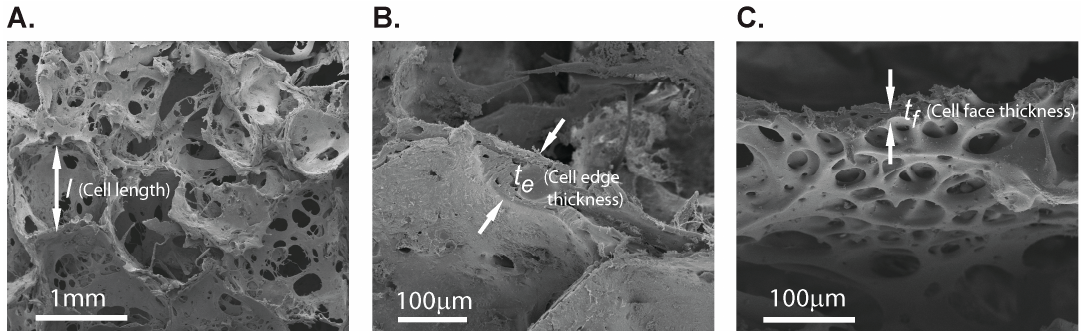
Figure 6. Scanning electron microscope (SEM) micrographs show microstructural differences. ( A ) Network scaffolds show highly porous structures with plate like cell walls; ( B ) Matrix hydrogels show relatively denser microstructures; ( C ) Composite scaffolds show dense areas of matrix hydrogel and the network cell walls.